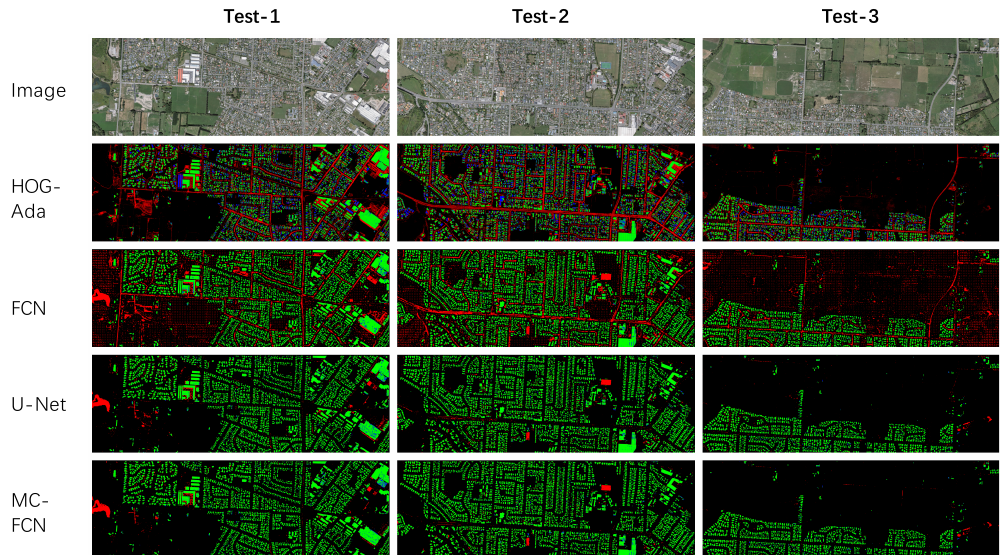
Figure 4. Segmentation results of HOG–Ada, FCN, U–Net and MC–FCN for the Test-1, Test-2 and Test-3 regions. The green, red, blue and black pixels of the maps represent the predictions of true positive, false positive, false negative and true negative, respectively.